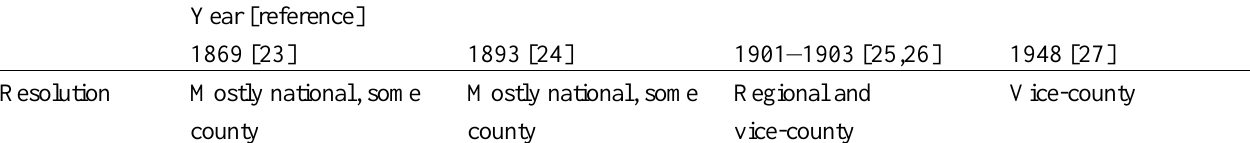
Table 4. Recording history of amphibians and reptiles in